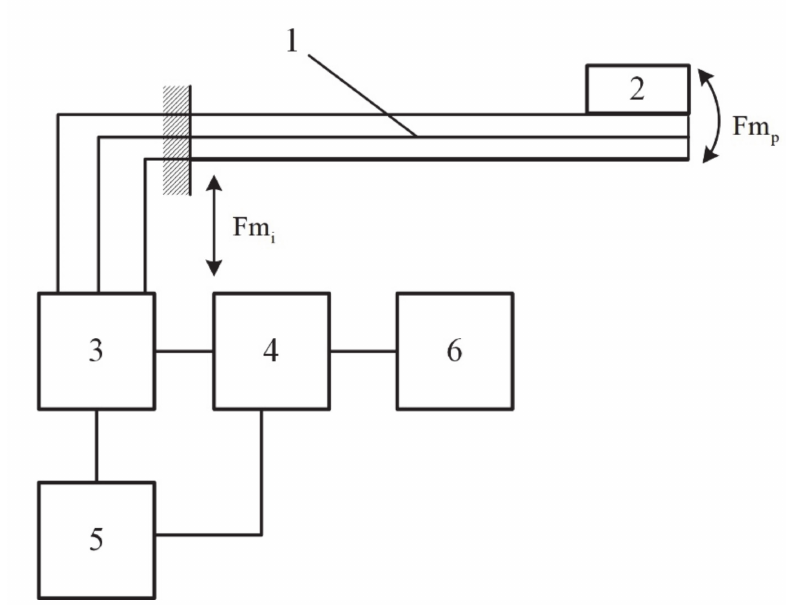
Figure 19. The architecture of the wireless MFC-magnet energy harvester, 1–MFC-magnet energy harvester; 2–concentrated inertial mass for the tuning of resonant frequency; 3–connection unit; 4–controller; 5–electrical energy accumulator; 6–wireless transmitter; Fm p –a dynamic force acting the cantilever; Fm i –a dynamic force generated by the rotor